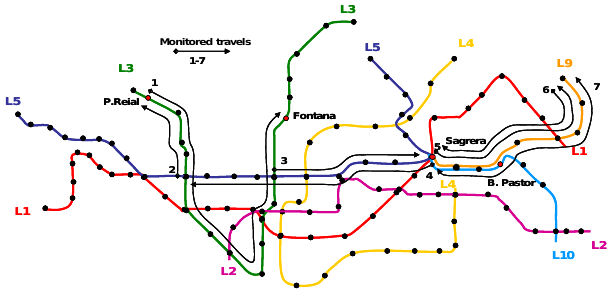
Fig. 1. Map of the Barcelona city metro system, with the location of the four stations where measurements were made on the platform, and the monitored journeys with real time measurements inside the train carriages (black lines 1 to 7).